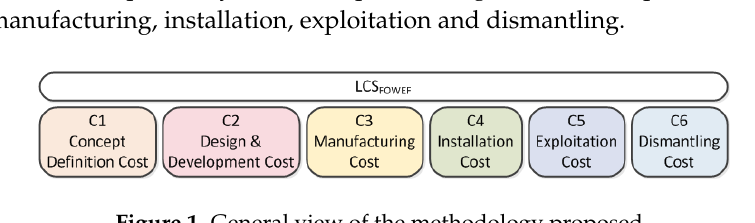
Figure 1. General view of the methodology proposed.